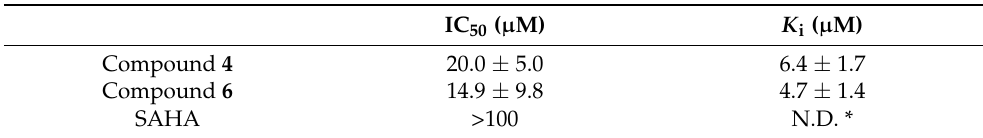
Table 2. The inhibition effectiveness of Compound 4 and 6 by inhibitory potency (IC 50 ) and affinity strength ( K i ) of